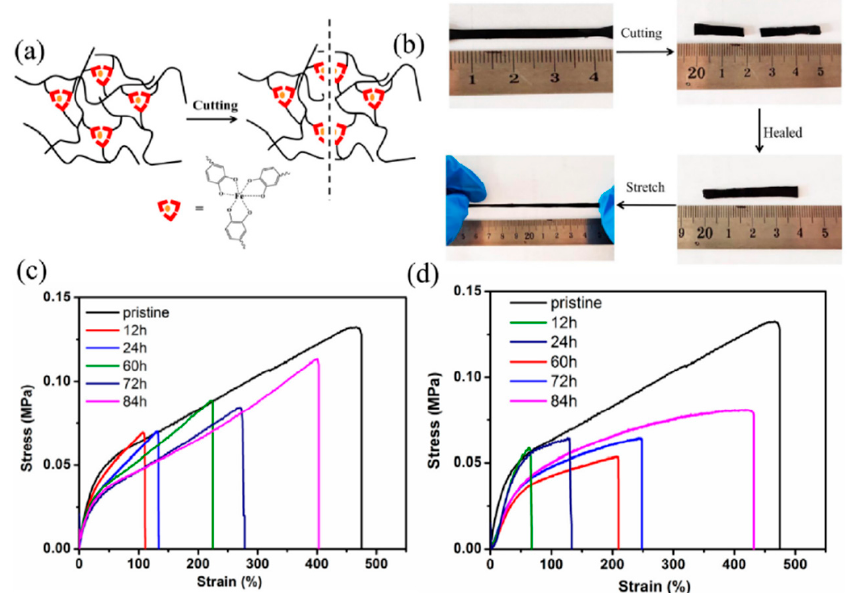
Figure 9. Self-healing of silicone elastomer via amino groups and mechanical properties; ( a ) network structure of silicone elastomer, ( b ) self-healing testing in silicone elastomer, ( c , d ) stress–strain curves of healed samples at various healing times for 120 °C and underwater (pH = 9) [90]. Reprinted from [90], Copyright 2020, with permission from Elsevier.